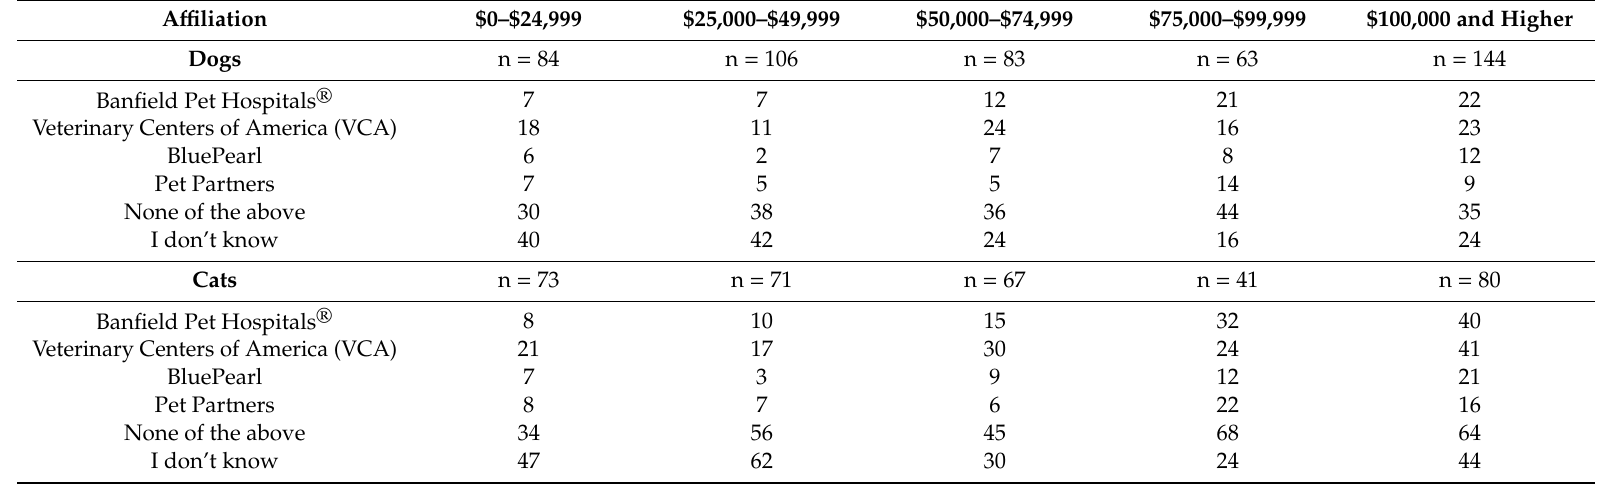
Table A6. A ffi liation of veterinary clinic respondent most often frequents, by